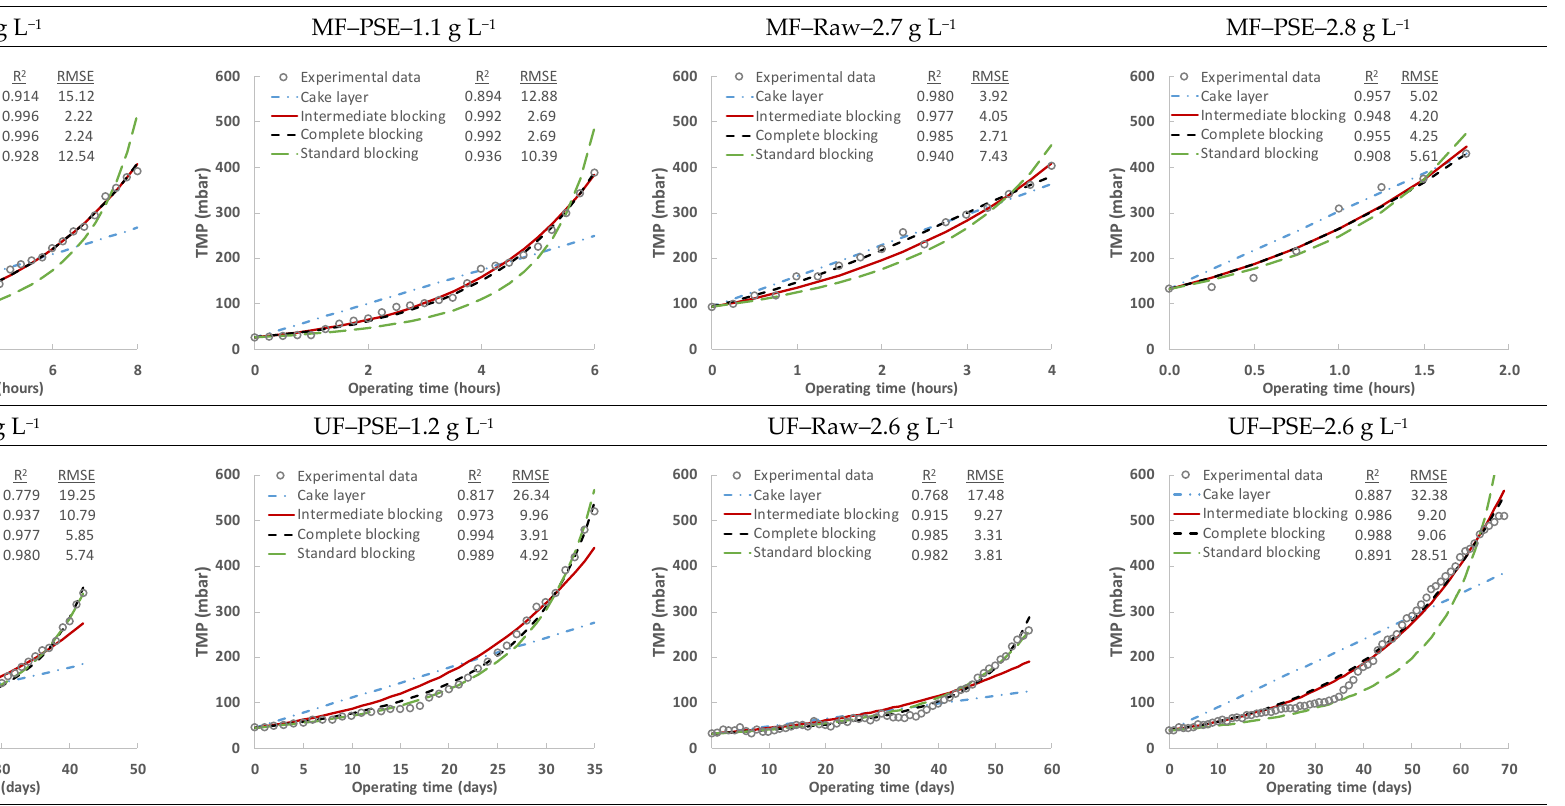
Figure 8. Fitting of the specific fouling mechanism models (cake layer, intermediate blocking, complete blocking and standard blocking models) to the hourly (MF membrane) and daily (UF membrane) TMP evolution obtained during the direct filtration of MWW. R 2 and RMSE represent the square of the Pearson correlation and the root-mean-square error, respectively. Raw: influent municipal wastewater after a classic pre-treatment (screening and sieving, desanding and degreasing). PSE: effluent of the full-scale wastewater treatment plant primary settler.